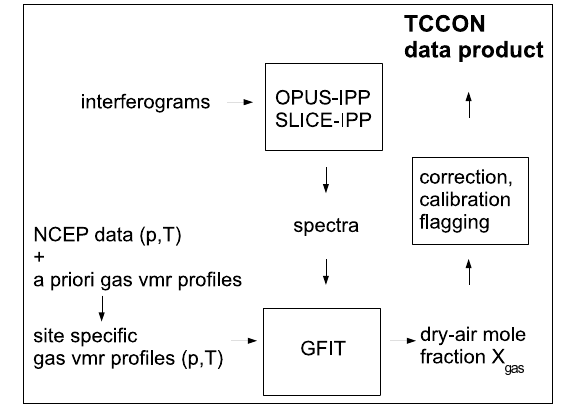
Fig. 4. The TCCON standard retrieval. The measured interfero- grams are transformed into spectra with the OPUS-IPP or SLICE- IPP software. The initial vertical gas mole fraction profile, the a priori profile, is approximated with NCEP/NCAR analysis data for the measurement site and day. In GFIT this a priori profile, along with spectra e.g. of the HITRAN database (Rothman et al., 2009) and the modeled atmospheric data, is used to calculate a theoreti- cal spectrum. This spectrum is then scaled to provide the best fit to the measured spectrum. After correction, calibration and data flag- ging, the TCCON product are column-averaged dry-air mole frac- tions X gas